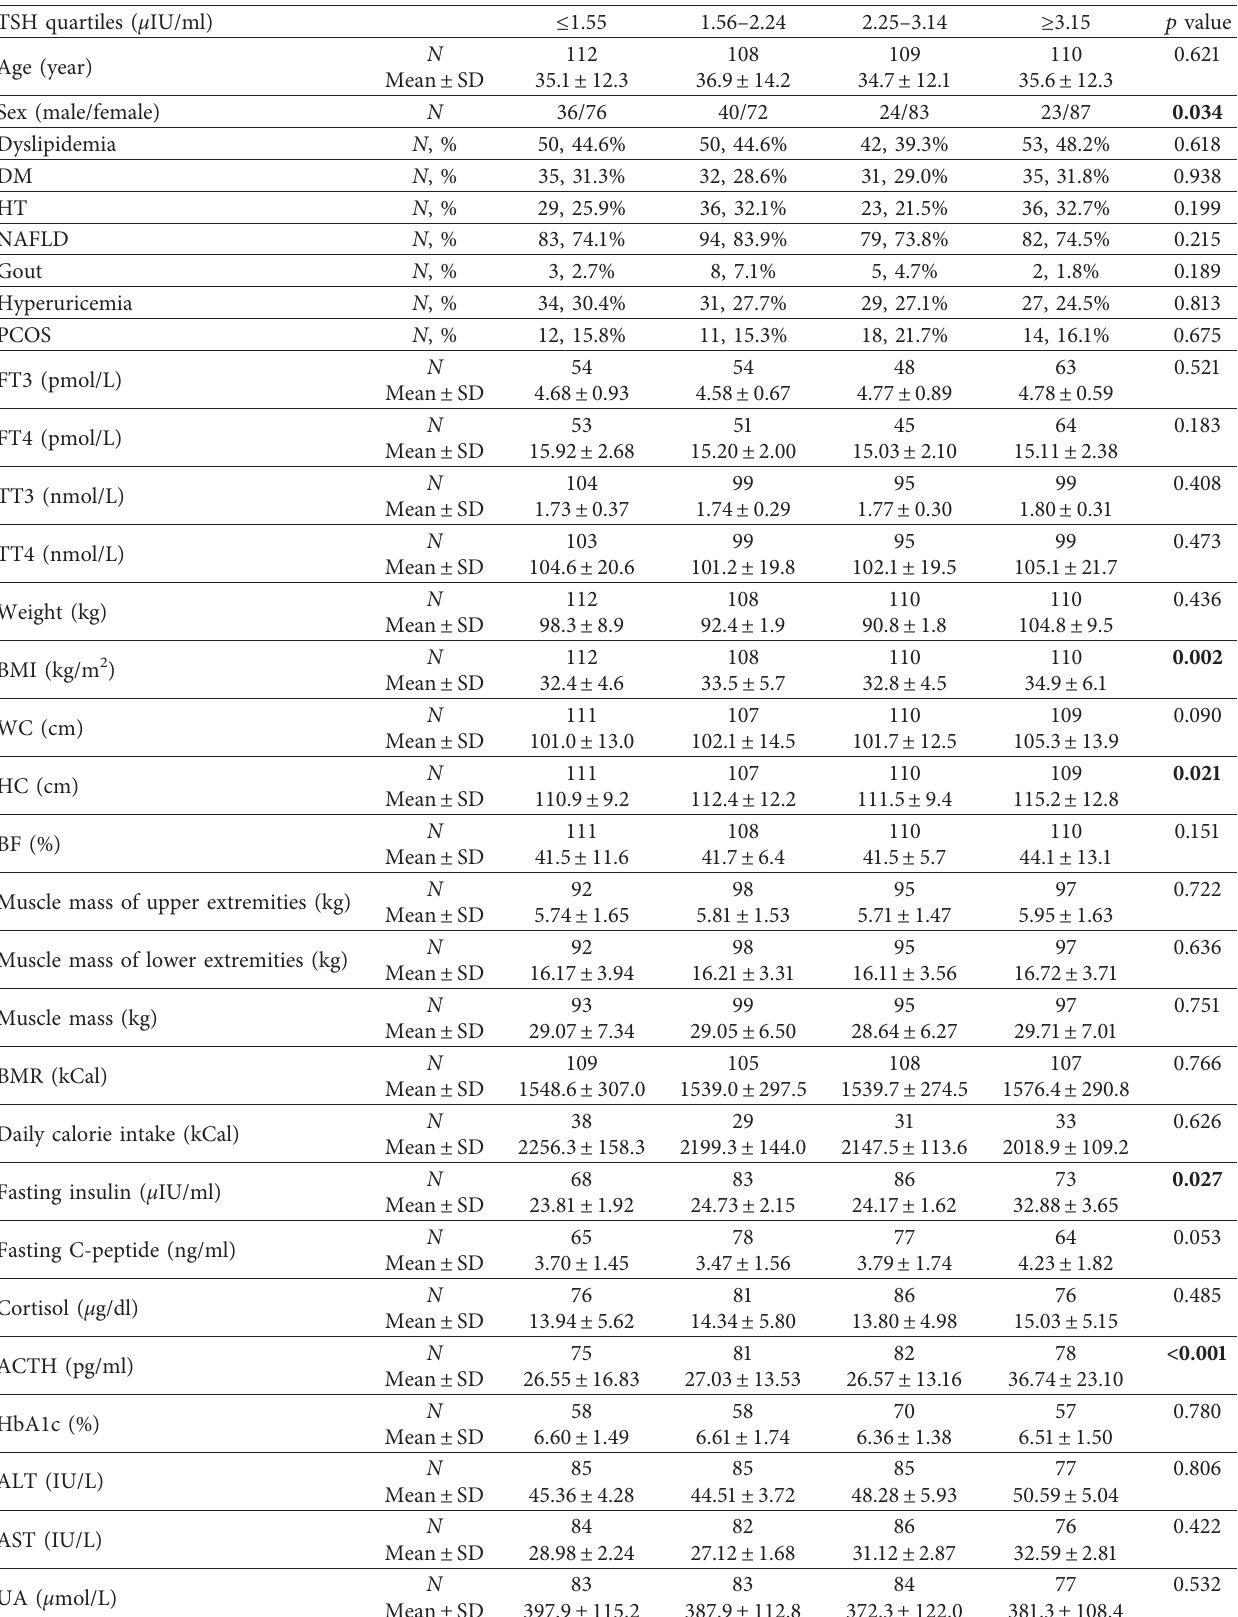
Table 1: The distribution of demographic data and metabolic indicators across the TSH quartiles in overweight or obese individuals. TSH quartiles ( μ